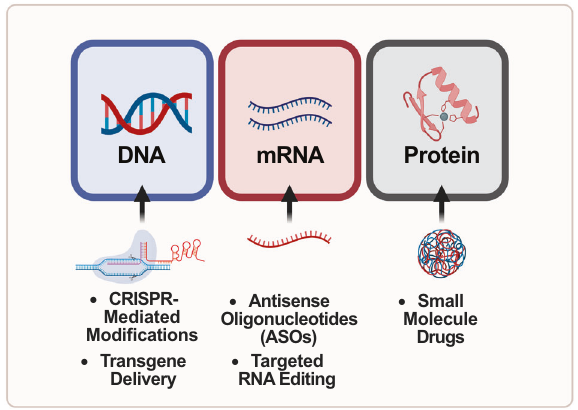
Fig. 1 Overview of therapeutics for ASD at different levels of the Central Dogma of Molecular Biology that were discussed in this review. The fi gure lists therapeutics linearly based on the natural progression of gene expression. In the fi rst column, small molecule drugs and CRISPR-based therapeutics are usually developed to treat diseases at the DNA level. In the second column, antisense oligonucleotides (ASOs) are usually developed to treat diseases at the mRNA level. In the third column, small molecule drugs are usually developed to treat diseases at the protein level. Speci fi c examples of each of these therapeutics are described throughout the oligonucleotides (ASOs) at both, the transcriptional and post- transcriptional level, and the use of small-molecule drugs to target molecular pathways at the translational, or protein level. This review will analyze the advantages and disadvantages of the various techniques across the central dogma in order to rescue ASD-associated phenotypes.